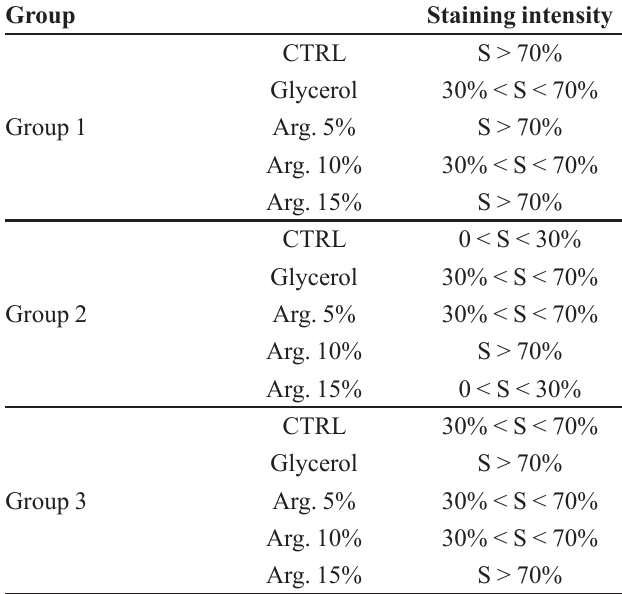
TABLE I - Evaluation of collagen fibers stained in female mouse skin Group